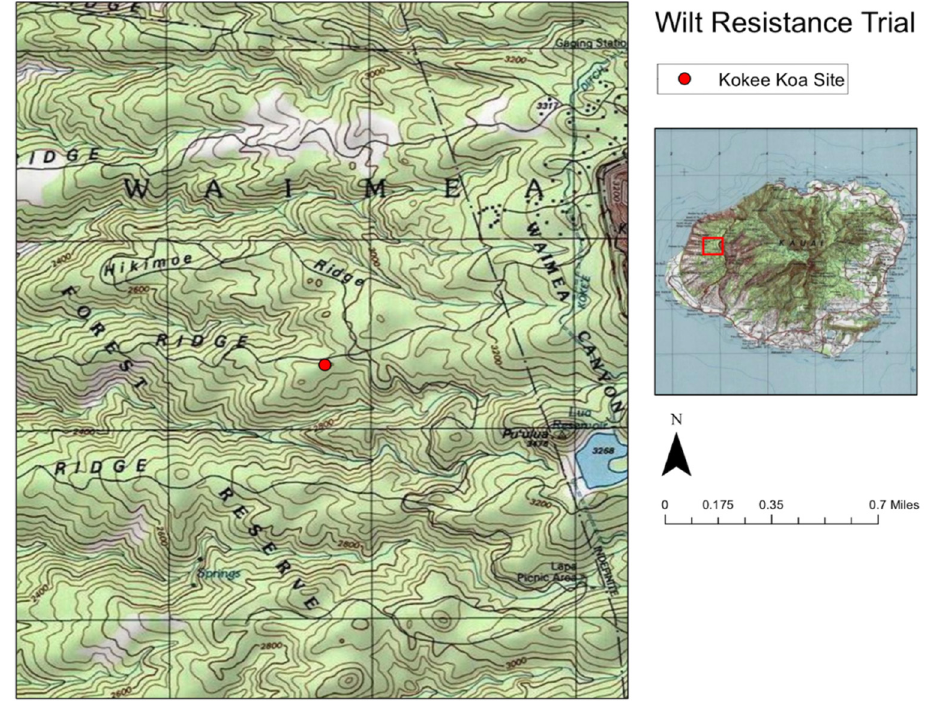
Figure 4. The wilt resistance trial (red dot) located on Polihale Ridge Road in Kokee on the west side of Kauai, HI, USA (inset map).